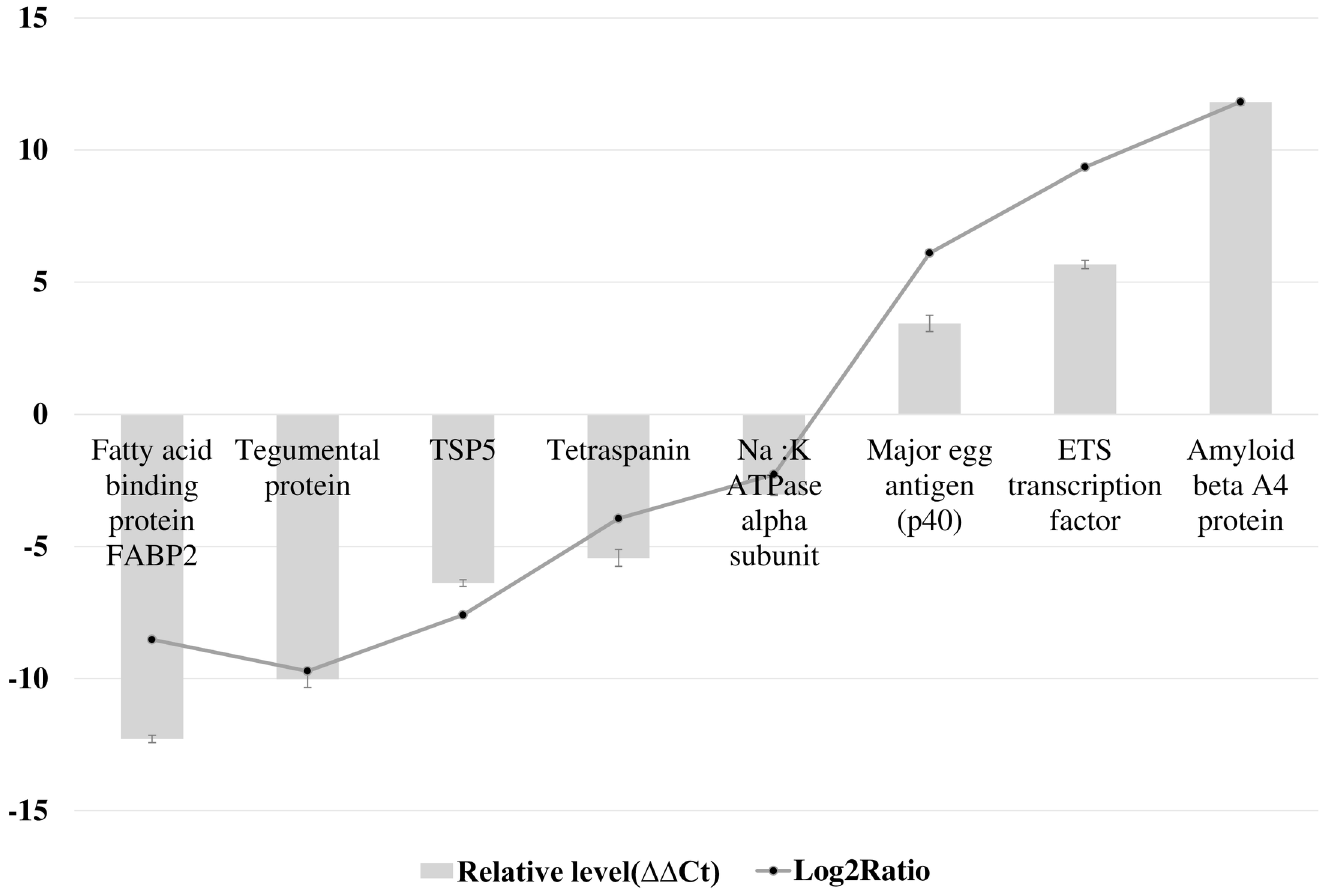
Fig 2. Real-time PCR validation of genes at kinds of expression level. The y-axis indicates the value of relative expression level (2 - ΔΔ Ct ) by real-time PCR and log 2 Ratio of Nonc1/Cmet by Next-generation sequencing. GAPDH as the internal control. Error Bar: Standard Deviation of the mean expression values of Real-time PCR.